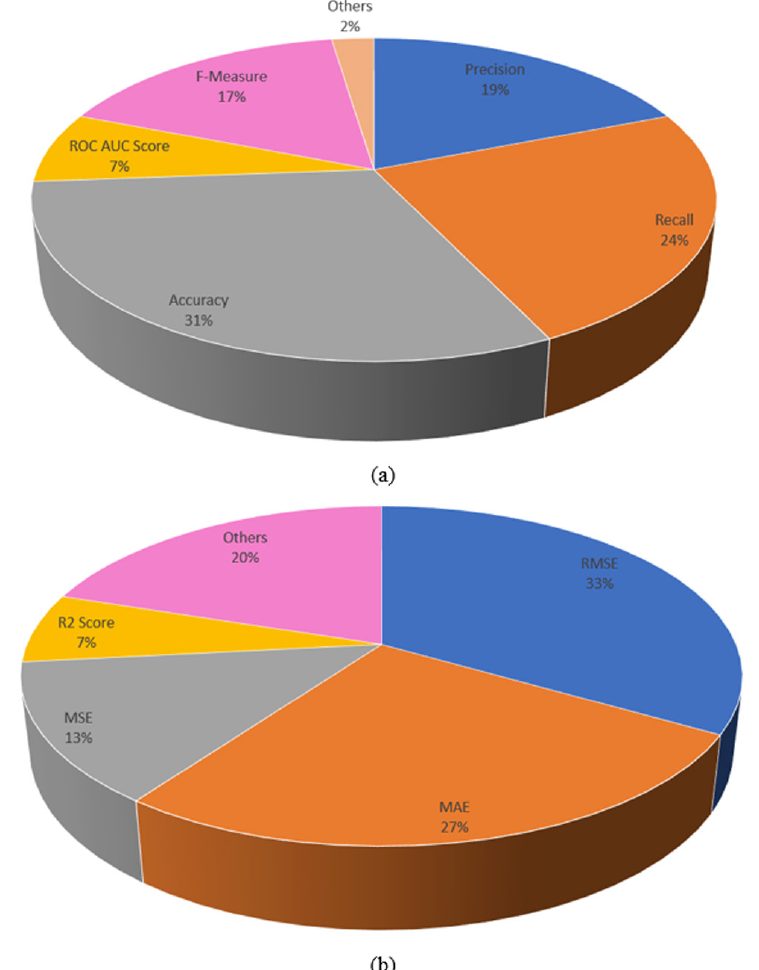
Figure 6. The frequency of evaluation metrics considered in the student performance prediction studies: ( a ) classification and ( b ) regression.